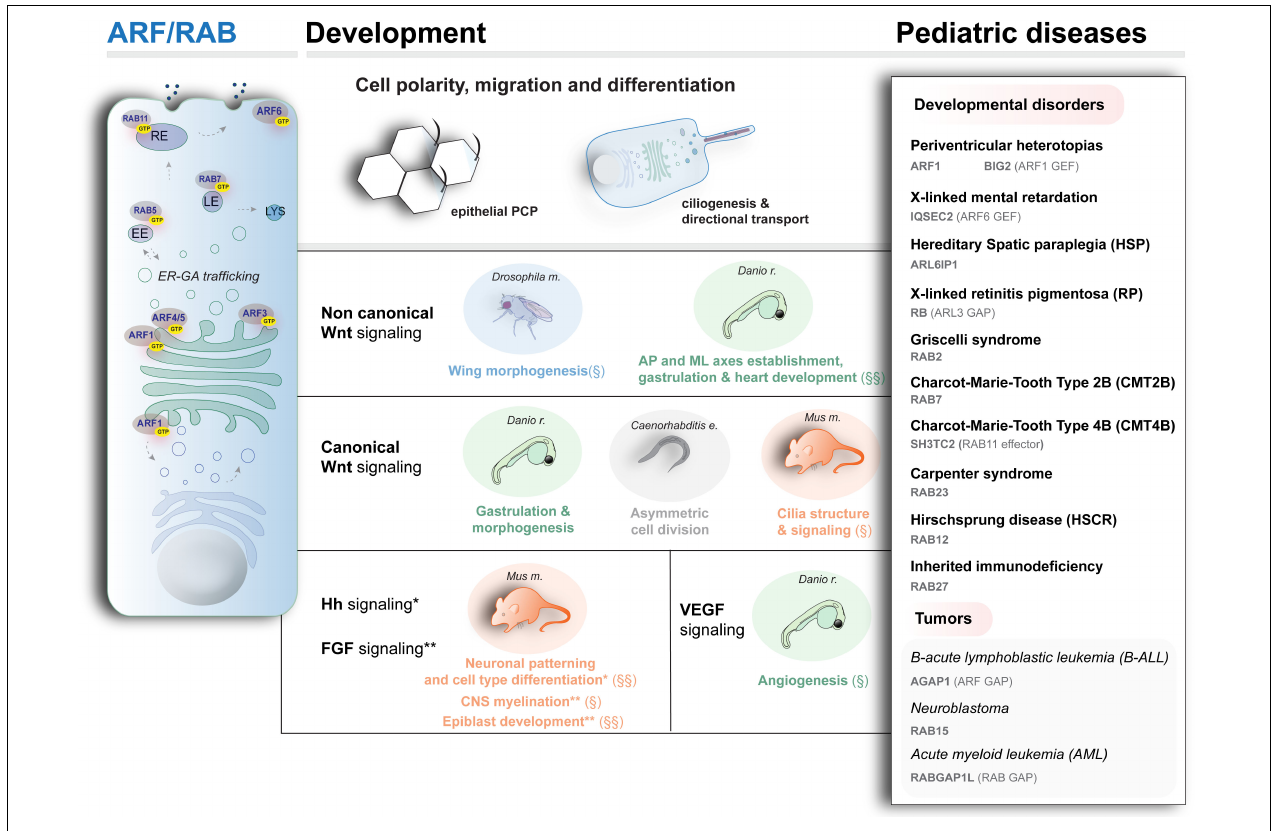
FIGURE 3 | Schematic representation of intracellular trafficking and organelles associated with ARF and RAB activity (left), the main developmental pathways and processes modulated by vesicular trafficking (center), and examples of rare diseases caused by mutant ARF and RAB proteins. § and §§ indicate processes associated with ARF and RAB proteins, respectively. No symbol indicates evidence for processes involving both ARF and RAB activity. EE, LE, RE: early, late, and recycling endosomes, respectively. LYS: lysosomes. For the disease genes and diseases depicted here, besides the literature cited in the text, refer to Novarino et al. (2014); Wakil et al. (2019) ( ARF-like 6 interacting protein 1 mutations in neuropathy with spastic paraplegia, microcephaly, leukoencephalopathy, and seizures); Griscelli and Prunieras (1978) (mutations in RAB2 in Griscelli syndrome affecting the immune system); Cogli et al. (2009); Lupo et al. (2009); Stendel et al. (2010), for the motor and sensory neuropathies Charcot–Marie–Tooth type 2B and type 4 (CMT2B and CMT4), caused by mutations in RAB7 and RAB11 effector SH3TC2, respectively; Harvey et al. (2010) (mutations in the ARF-specific GAP encoding gene AGAP1 in pediatric high-risk B-cell ALL); Roberti et al. (2009) (gene rearrangement in the RAB-specific GAP encoding gene RABGAP1L in patient with Klinefelter syndrome who developed